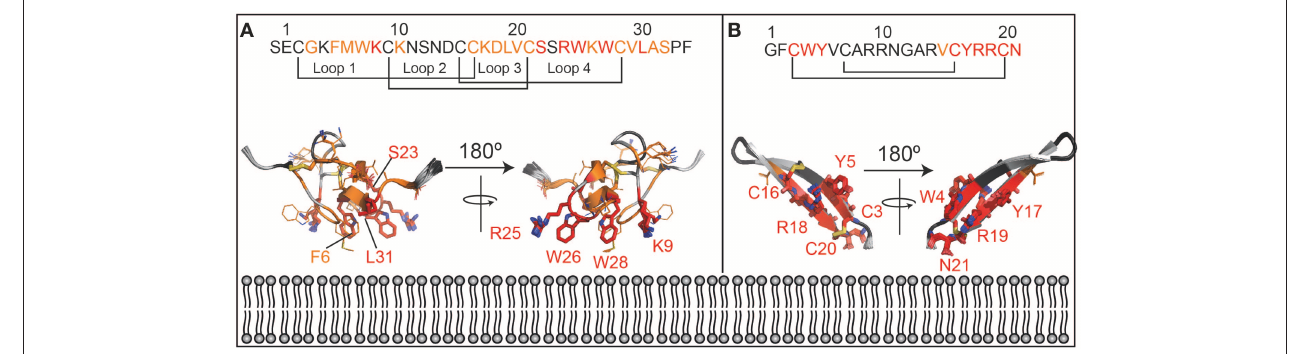
FIGURE 4 | Lipid interaction of membrane-active peptides. Cartoon representation of the peptides [ A = VSTx1 (PDBID: 2N1N), B = AA139 (PDID: 5V11)] are oriented to show the likely binding orientation with respect to the lipid bilayer (bottom) based on the NMR titration data (180 ◦ rotation also shown). Disulfide bonds are shown as sticks. The peptide sequences and numbering are shown above the peptides. The residues in red (sidechains as sticks and labeled) are those that show the strongest perturbation upon addition of nanodiscs, those in orange show an intensity change consistent with the binding isotherm (sidechains as sticks) and residues in dark gray show smaller perturbation that do not fit the binding isotherm. Residues that were not included in the analysis (missing/overlapped) are shown in light gray. Structures in panels (A) and (B) are not to the same